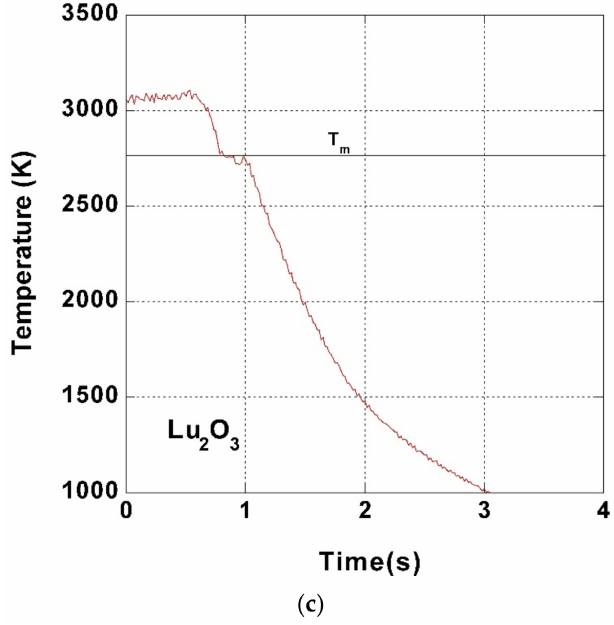
Figure 4. Time–temperature profiles obtained in each Ln 2 O 3 sample: ( a ) Tm 2 O 3 ; ( b ) Yb 2 O 3 ; ( c ) Lu 2 O 3 . All the samples were successfully recovered and returned to Earth. The samples were entirely white (Figure 3b), indicating that the reduced sample surfaces were oxidized and back to original Ln 2 O 3 compositions at high temperatures. Typical sample masses before and after the flight experiments are listed in Table 2. Slight mass losses are identified due to evaporation during the experiment. The densities were determined using the final masses weighed on the ground. The results are shown in Figure 5 and summarized in Table 3 with the literature values. Moreover, detailed density values are provided as a Supplementary Material.